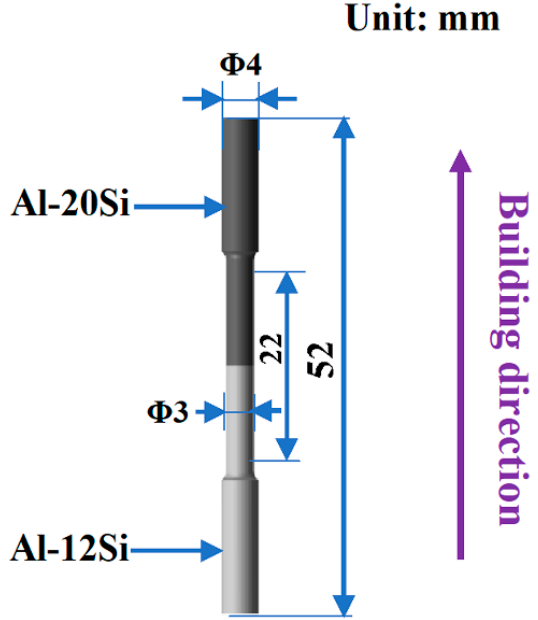
Figure 2. Schematic diagram of tensile samples of Al–(12-20)Si bi-material.